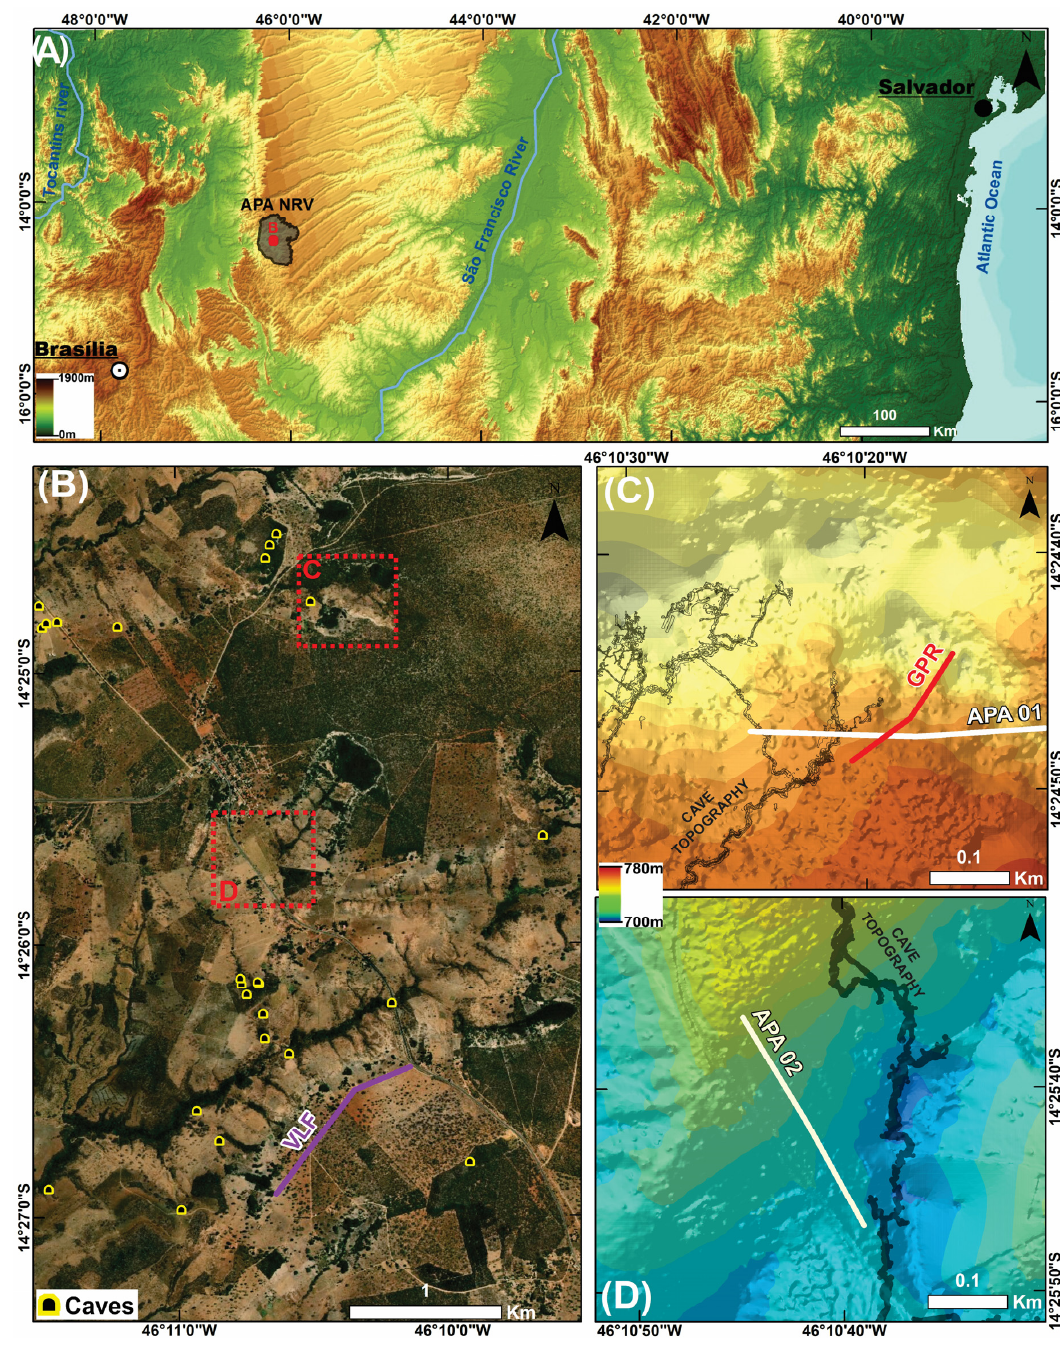
Figure 1. ( A ) Location of the environmentally sensitive area of the River Vermelho on the map of Brazil. ( B ) Locations of studied sites in proximity to the Tarimba cave and over a pavement where Very Low Frequency Electromagnetic (VLFEM) data were acquired. ( C ) Zoomed image of Site ‐ C on high ‐ resolution Digital Terrain Model along with a portion of Tarimba cave, the Ground Penetrating Radar (GPR) and Electrical Resistivity Tomography (ERT) survey lines. ( D ) Zoomed image of the Site ‐ D where a resistivity (APA01) profile was taken.